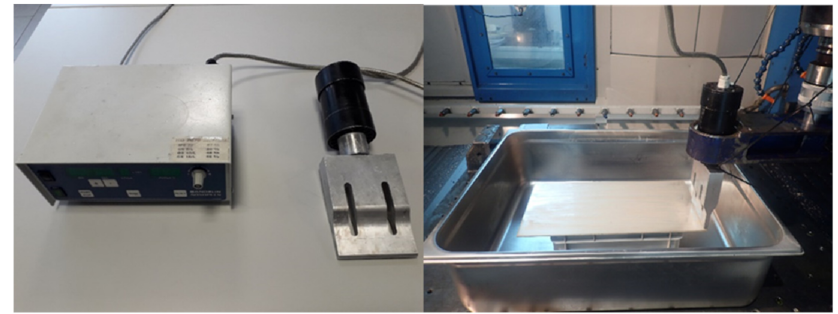
Figure 4. Cleaning equipment ( left ) and assembly on 3-axis machine ( right